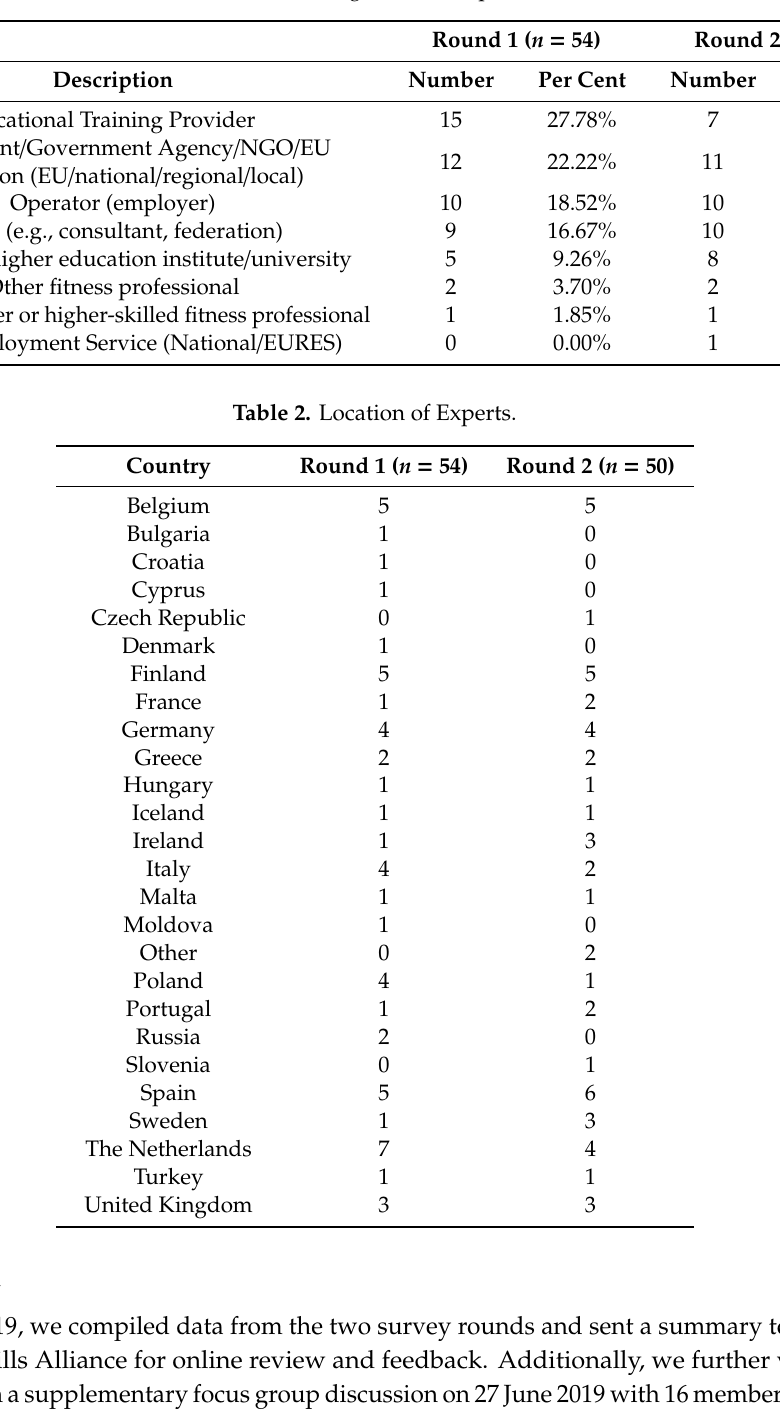
Table 1. Background of Experts.